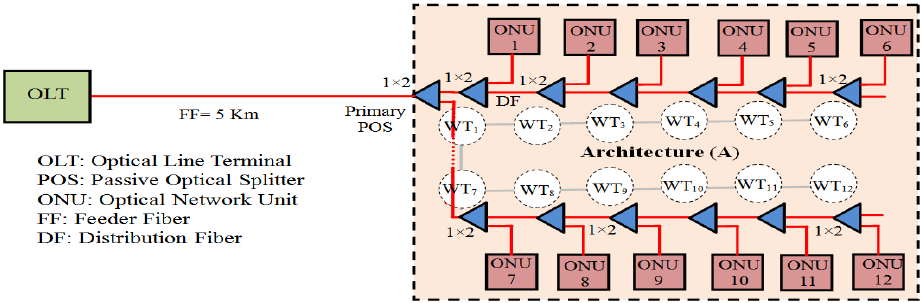
Figure 3. EPON ‐ based architecture (A).